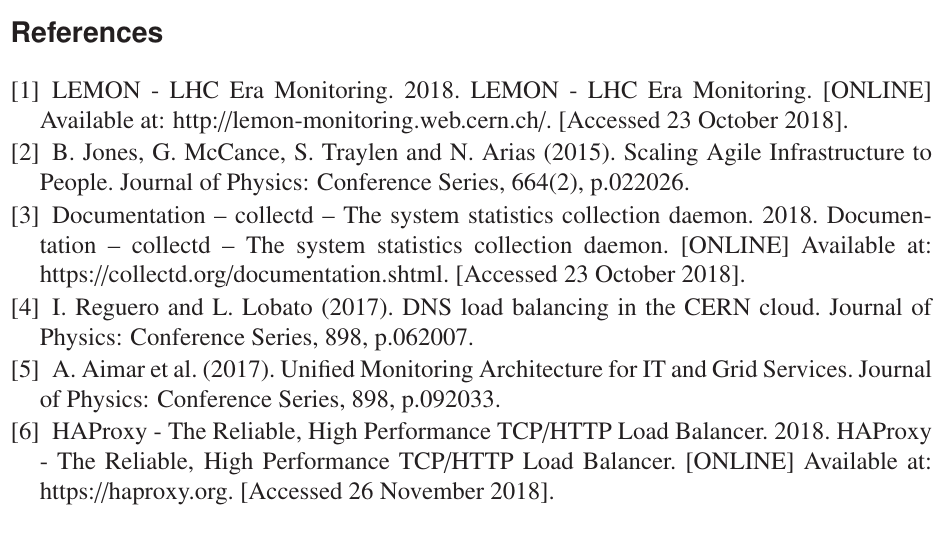
Figure 3: Monitoring of the nodes behind a particular alias.